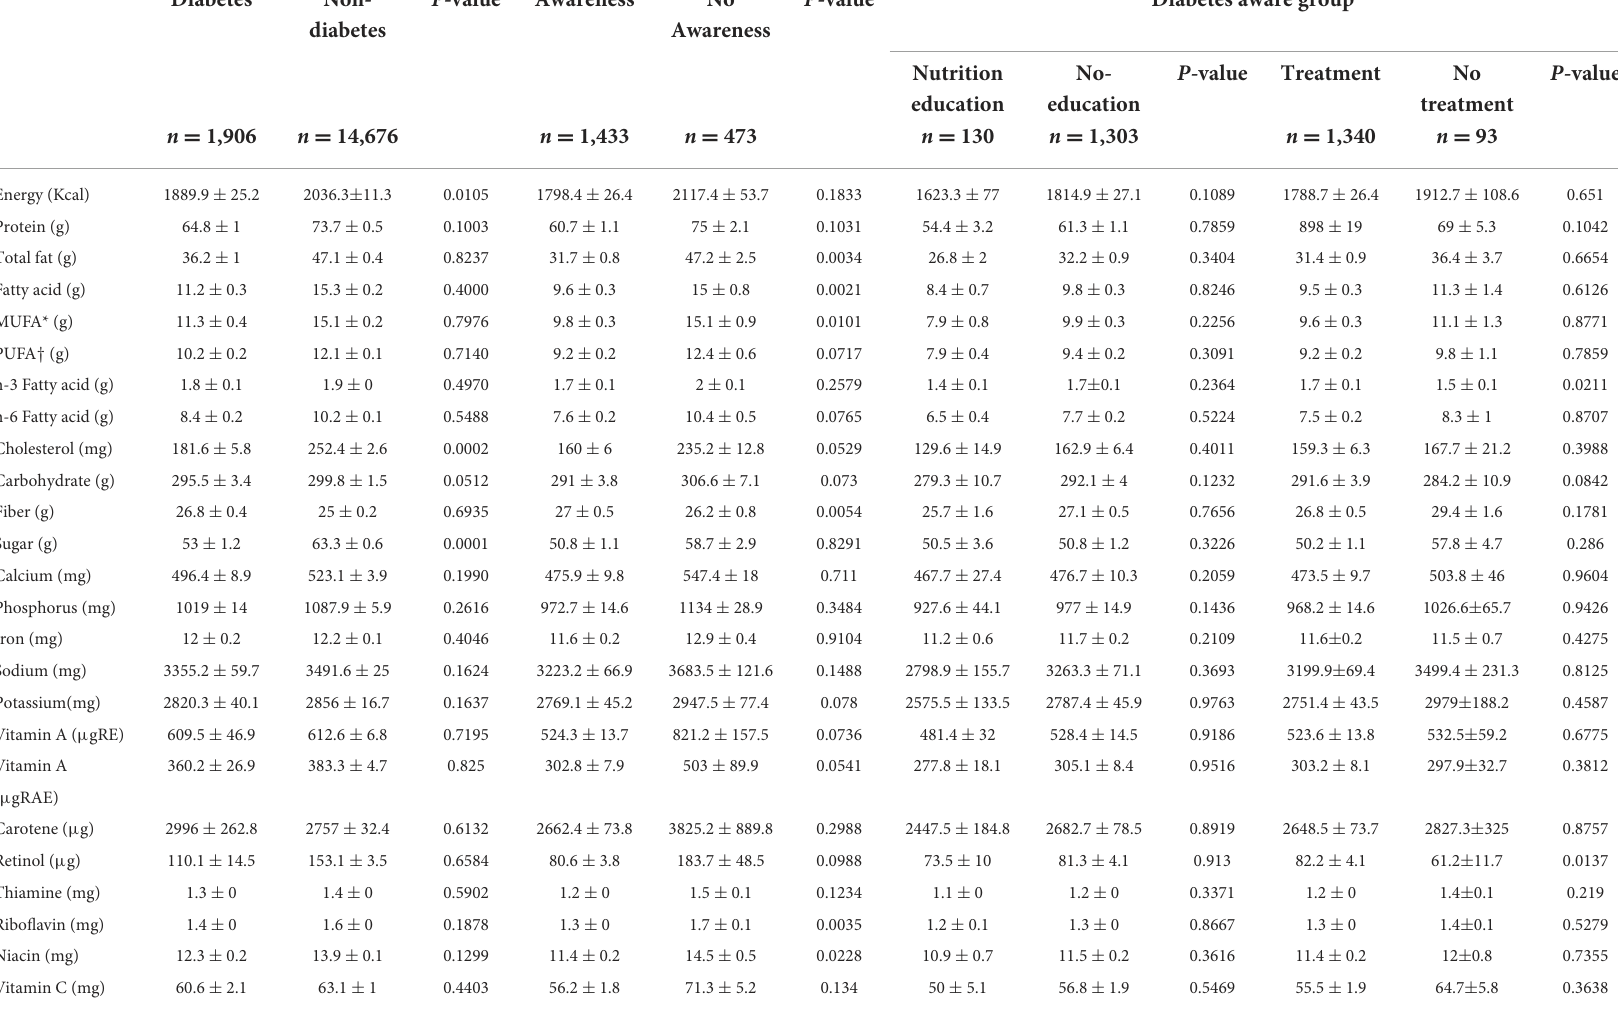
TABLE 2 Nutrient intake according to diabetes, aware and unaware, based on nutrition education and treatment or not in Korean adults. Diabetes